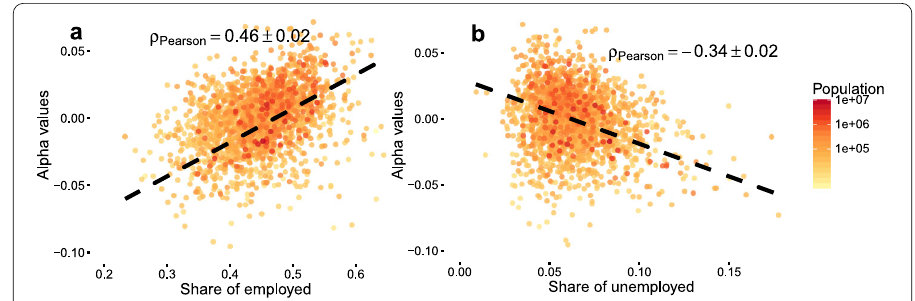
Figure 5 Scatterplots of 24-dimensional projected α ( k ) values with employment and unemployment.